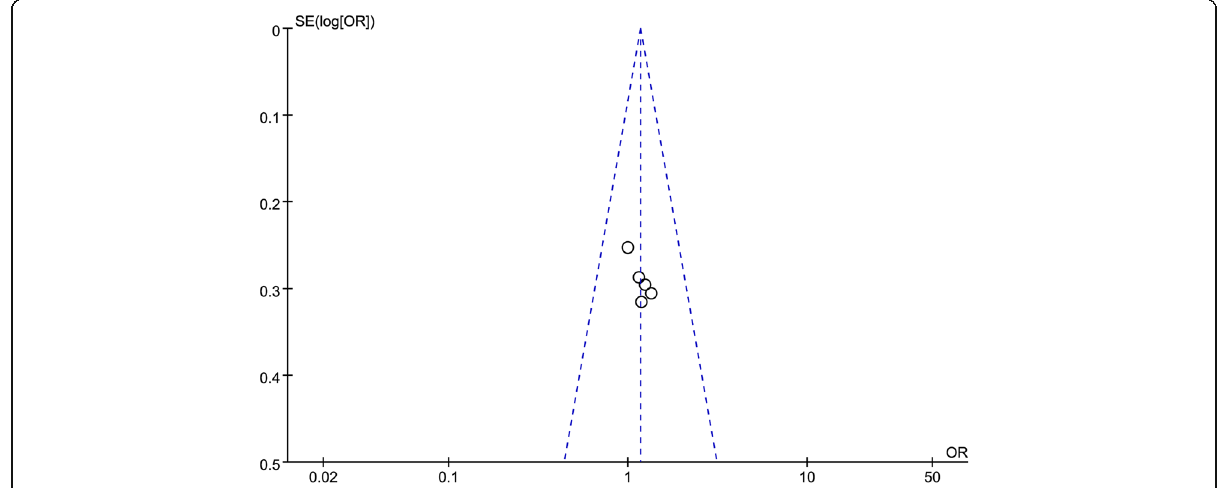
Fig. 9 Funnel plot of the meta-analysis showed no significant publication bias in total adverse events. SE = Standard error, OR = Odds